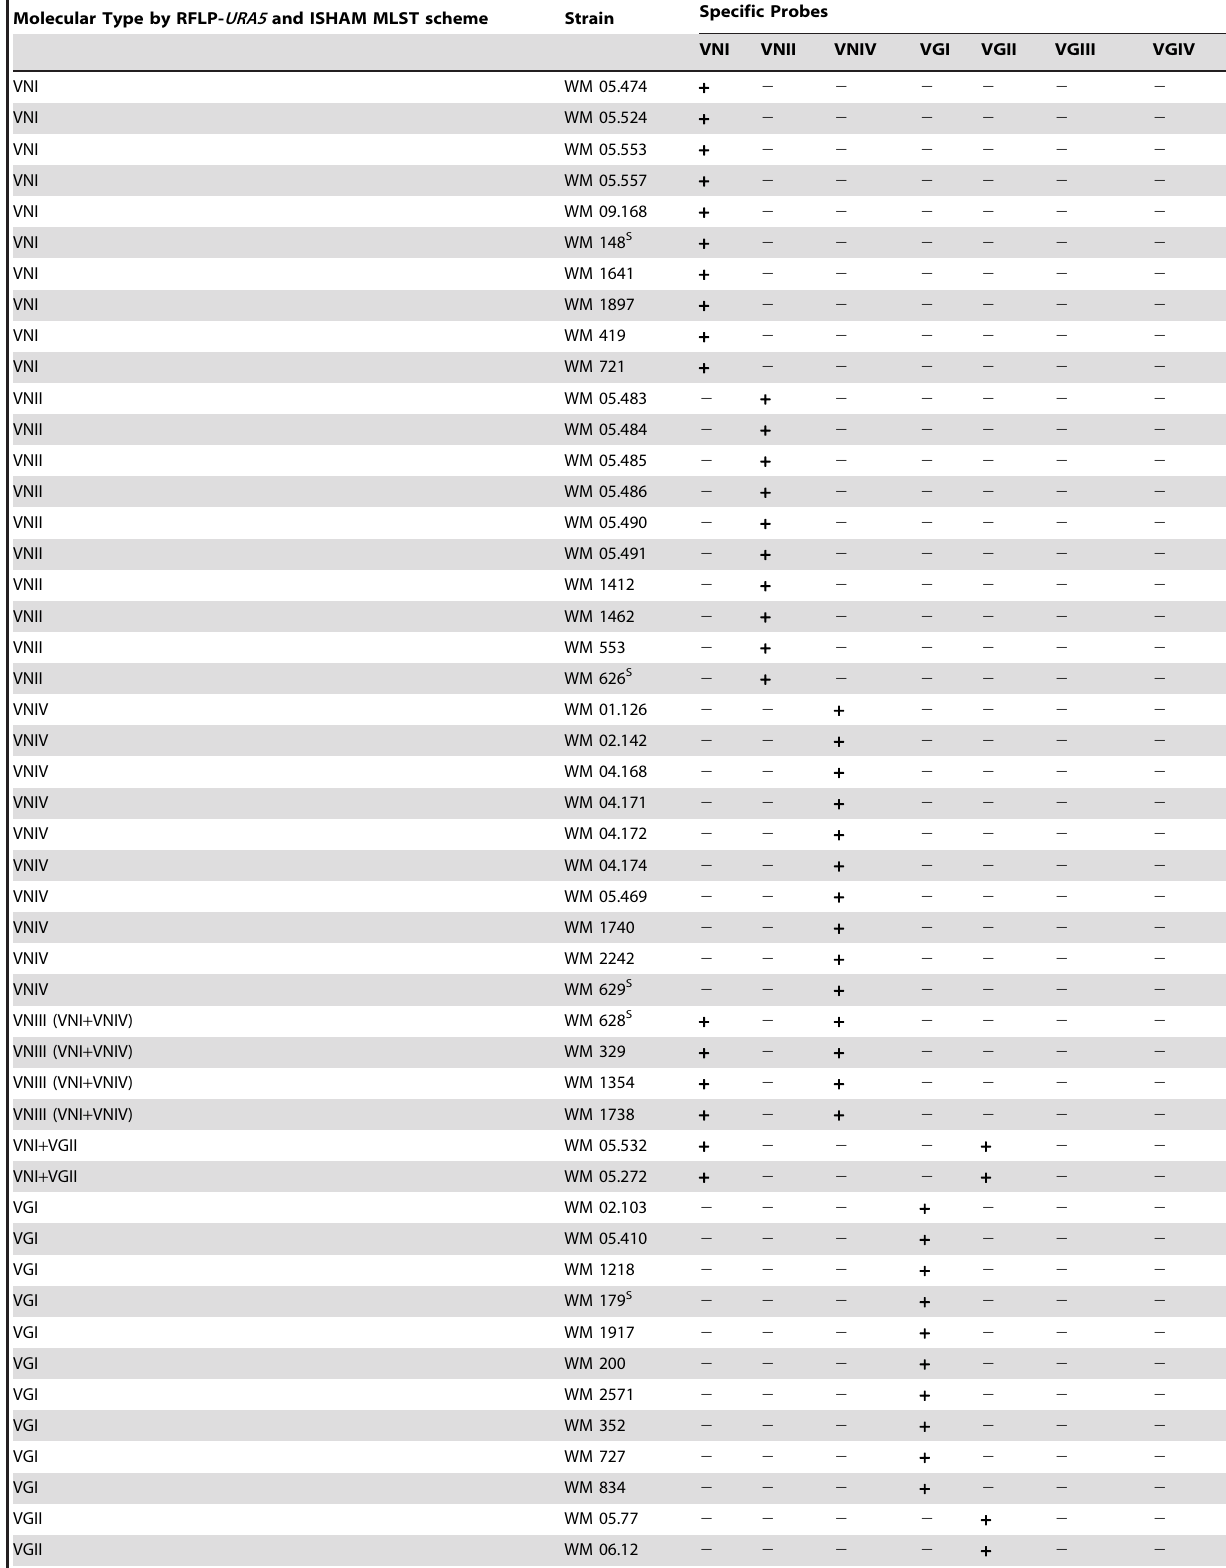
Molecular Type by RFLP- URA5 and ISHAM MLST scheme